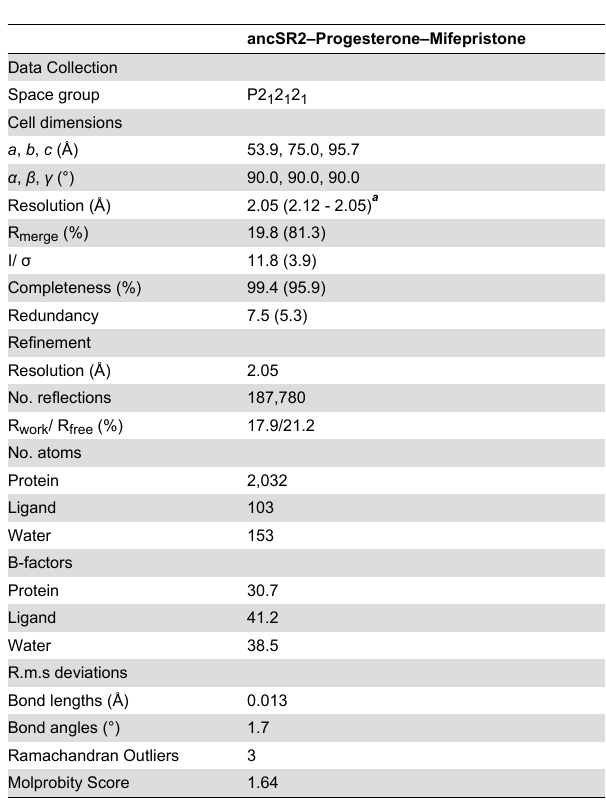
Table 1. Data Collection and Refinement Statistics.